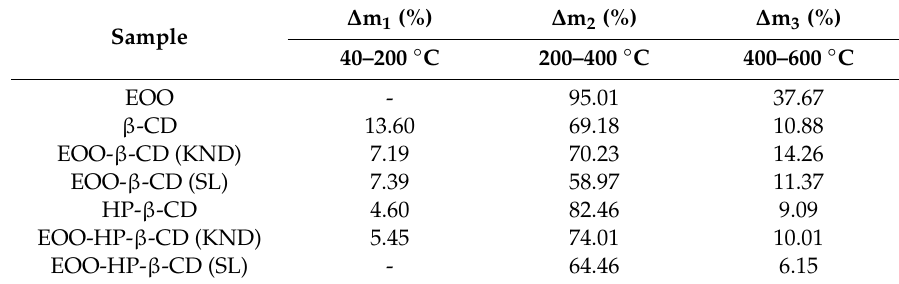
Table 2. Results of thermogravimetry analysis in terms of mass loss (%) in the temperature ranges